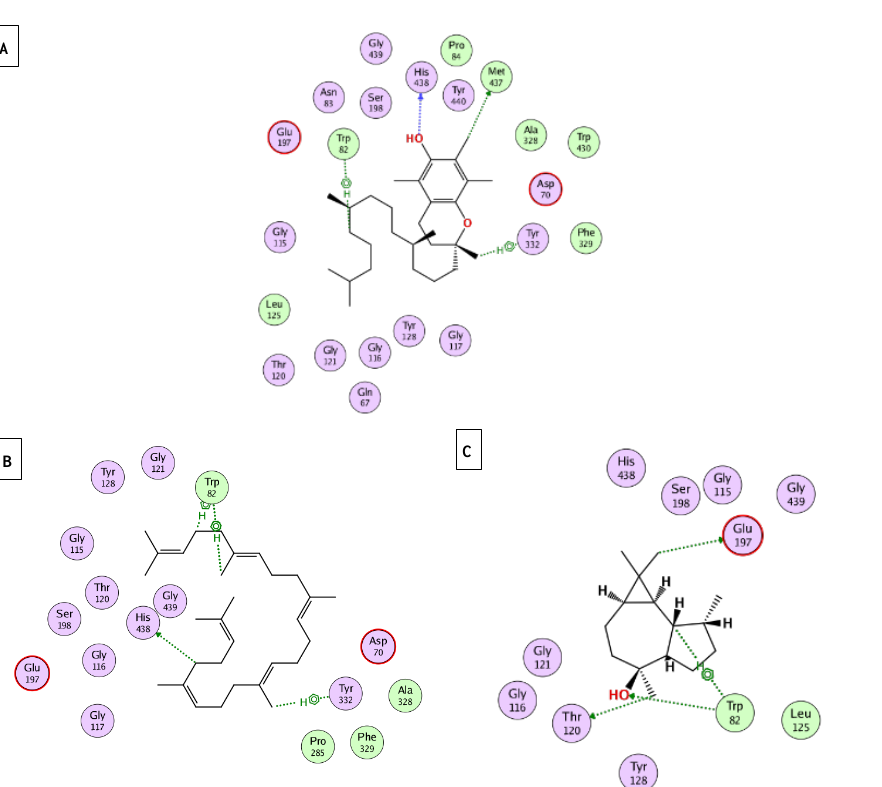
Figure 5. 2D binding modes of α -tocopherol ( A ); squalene ( B ); viridiflorol ( C ) to the active binding sites of BChE.